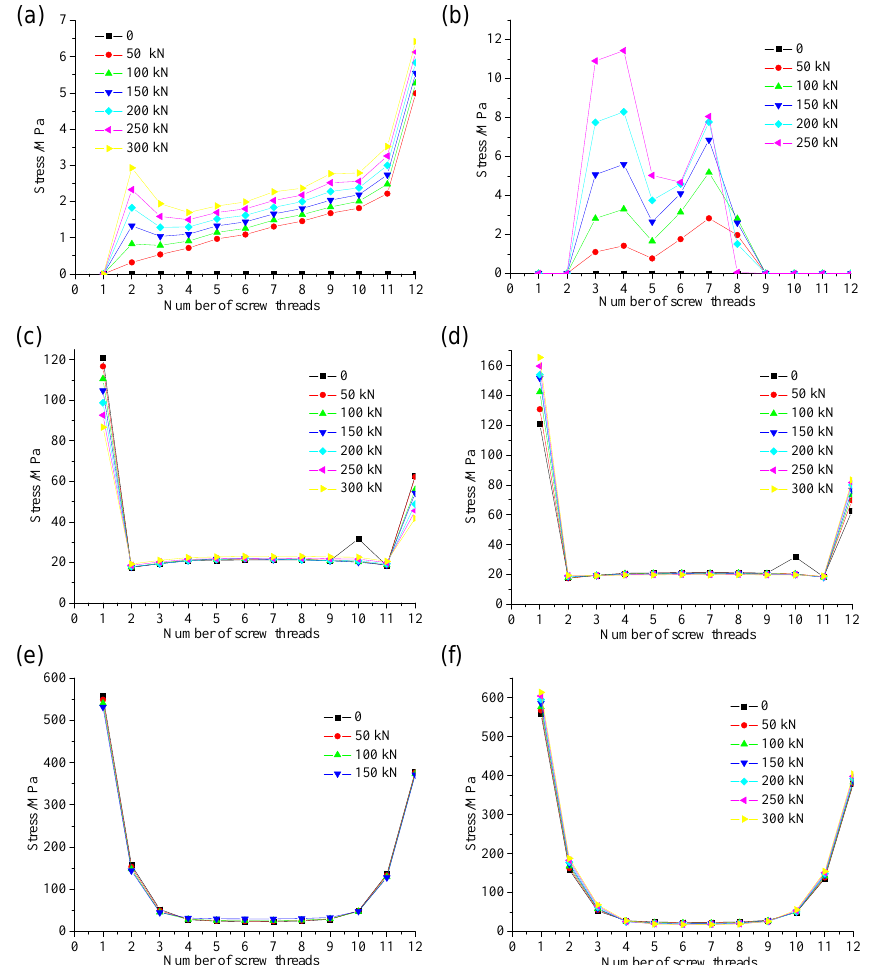
Figure 9. Stress change principle with different connection types: (a) tension stress in state A , (b) tensile stress in state A , (c) tension stress in state B , (d) tensile stress in state B , (e) tension stress in state C and (f) tensile stress in state C